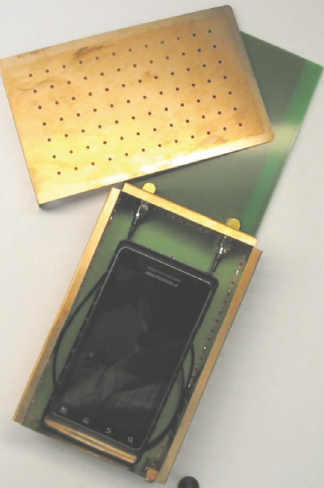
Figure 17: LTE reference antenna for UE with two antennas designedbyMotorolaMobilityforband13(751 MHz),withaprinted circuit board carrying a closed metal cavity for the UE, two printed antennas, and connection cables [28].